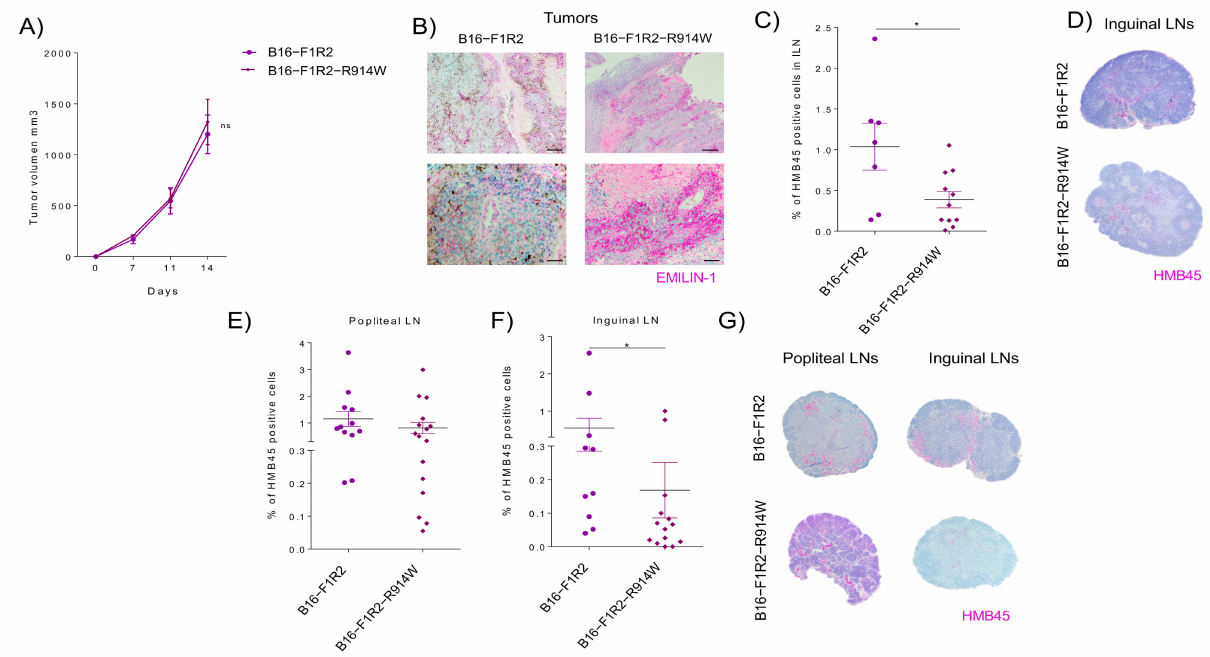
Figure 5. Analysis of EMILIN-1 stabilization mutant in vivo. ( A ) Tumor growth and lymph node metastasis of B16-F1R2 and B16-F1R2-R914W xenografts. C57BL/6 mice were injected subcutaneously with 1 × 10 6 B16-F1R2 ( n = 8 mice) and B16-F1R2-R914W ( n = 10 mice) cells. ( B ) Representative images of B16-F1R2 and B16-F1R2-R914W tumor sections stained for EMILIN-1. Bar: 100 µ m ( C ) Percentage of melanoma HMB45 positive cells quantification from inguinal lymph nodes were used for analyzed lymph node metastasis (B16-F1R2, n = 7 and B16-F1R2-R914W, n = 13) * p < 0.05 by Non-parametric t -test. ( D ) Representative images of inguinal lymph nodes (HMB45 staining) from B16-F1R2 and B16-F1R2 R914W xenografts. Bar: 500 µ m. ( E – G ) Analysis of lymph nodes from C57BL/6 mice injected intrafootpad with 200,000 B16-F1R2 and B16-F1R2- R914W cells. Percentage of melanoma HMB45 positive cells quantification from ( E ) popliteal (B16-F1R2 group n = 12 and B16-F1R2-R914W group n = 16) and ( F ) inguinal lymph nodes (B16-F1R2 group n = 10 and B16-F1R2-R914W group n = 14), * p < 0,05 by Non-parametric t -test. ( G ) Representative images of popliteal and inguinal lymph nodes (HMB45 staining) from C57BL/6 mice. Bar: 500 µ